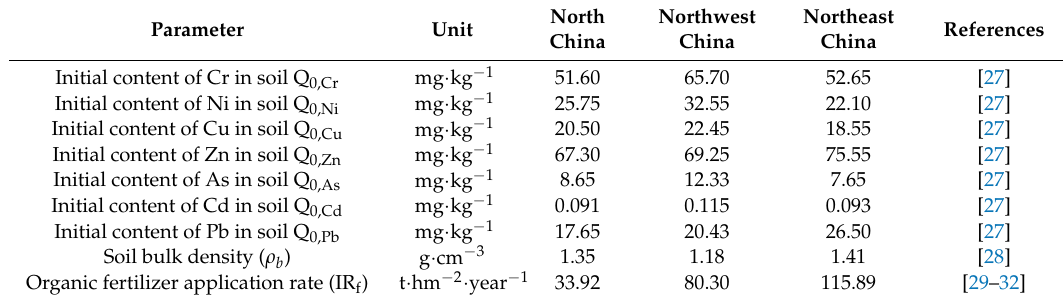
Table 2. Soil trace metal background value and organic fertilizer application rate. Parameter